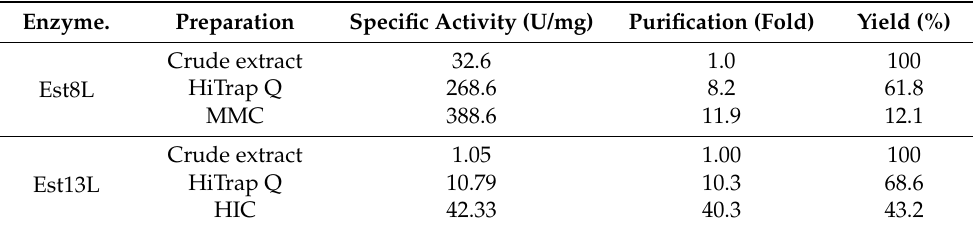
Figure 3. Gels of purified Est8L ( a ) and Est13L ( b ) after SDS-PAGE and staining with Coomassie blue. Red arrows in ( a ) and ( b ) indicate the predicted positions of Est8L and Est13L, respectively. C, crude extract; Q, HiTrap Q fraction; M, HiTrap capto MMC fraction; H, t -butyl HIC fraction. Through this procedure, the purification fold and yield of Est8L were 11.9% and 12.1%, respectively, and those of Est13L were 40.3% and 43.2%, respectively (Table 1). Table 1. Purification of Est8L and Est13L using chromatographic procedures.